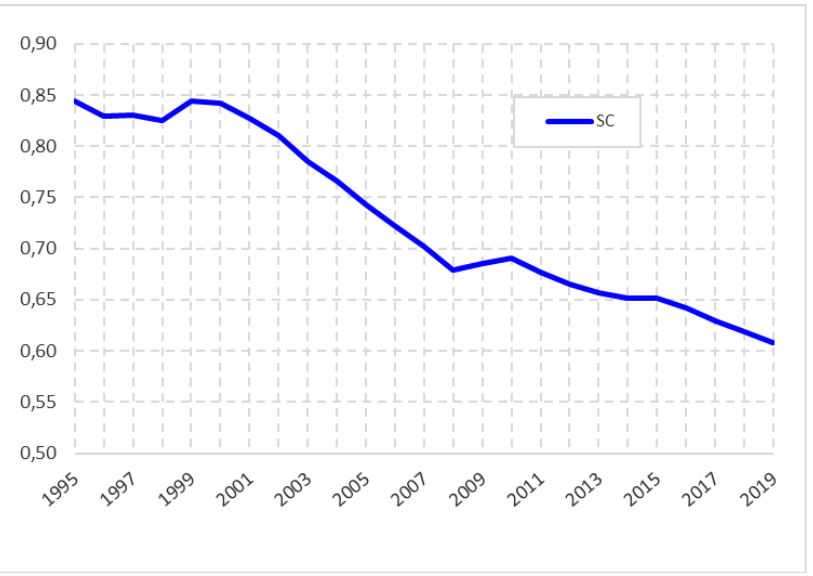
Figure 1. GDPpc’s Sigma convergence of EU-28 countries. Source: Prepared by authors based on Eurostat.